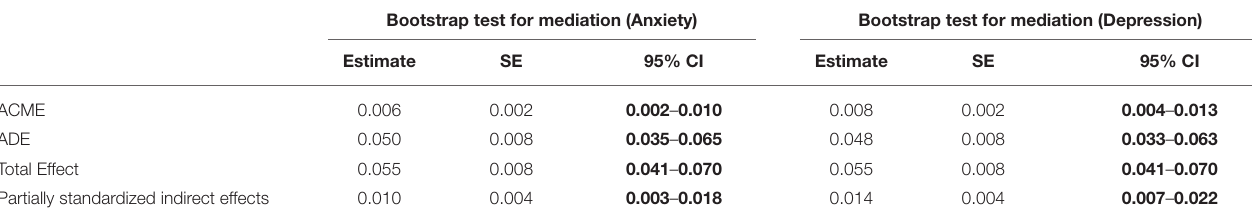
TABLE 5 | Bootstrap test ( n = 5,000) for mediation effect of in the association between emotional problems family function and self-efficacy *